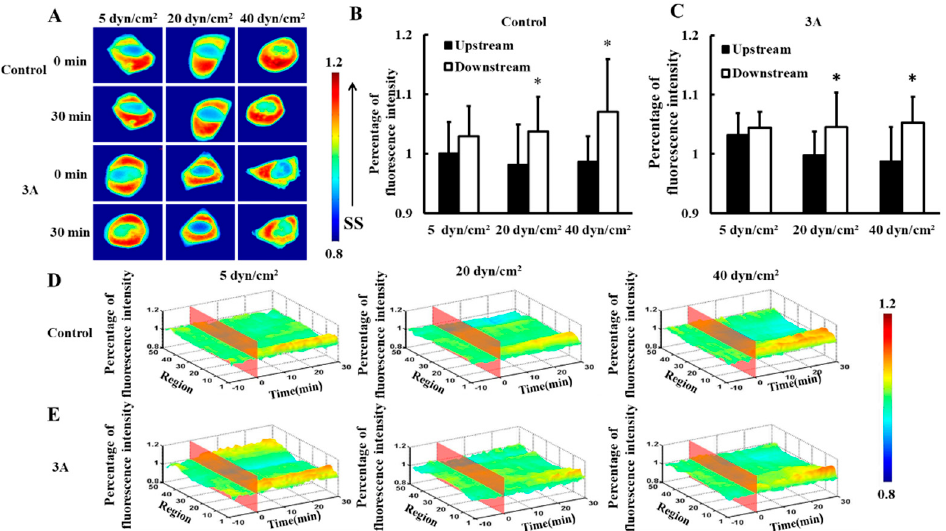
Figure 1. Effects of heat shock protein 27 (HSP27) phosphorylation on shear-stress-induced HSP27 polar distribution. ( A ) Fluorescence images of HeLa cells transfected with HSP27-Ypet (control) and